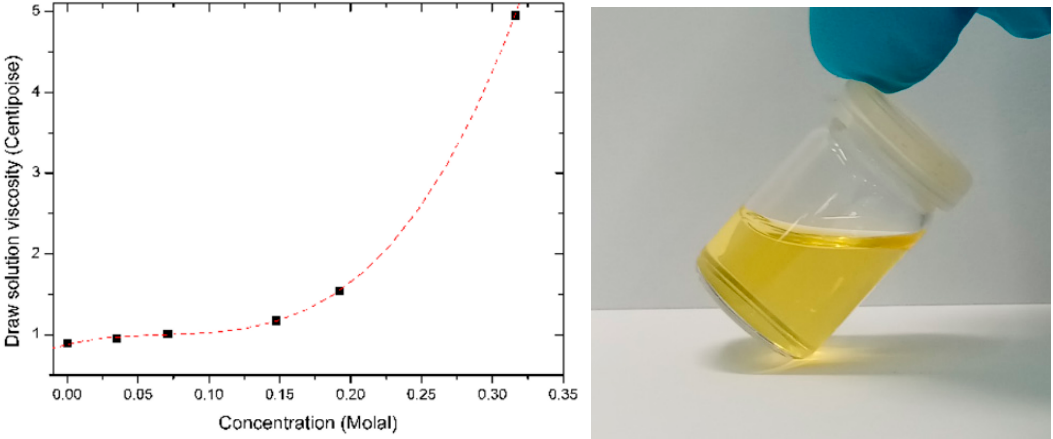
Figure 3. ( Left ): Viscosity of the ionosilica hydrogels at various concentration; ( right ): Photograph of a fluidic dispersion of ionosilica hydrogels.